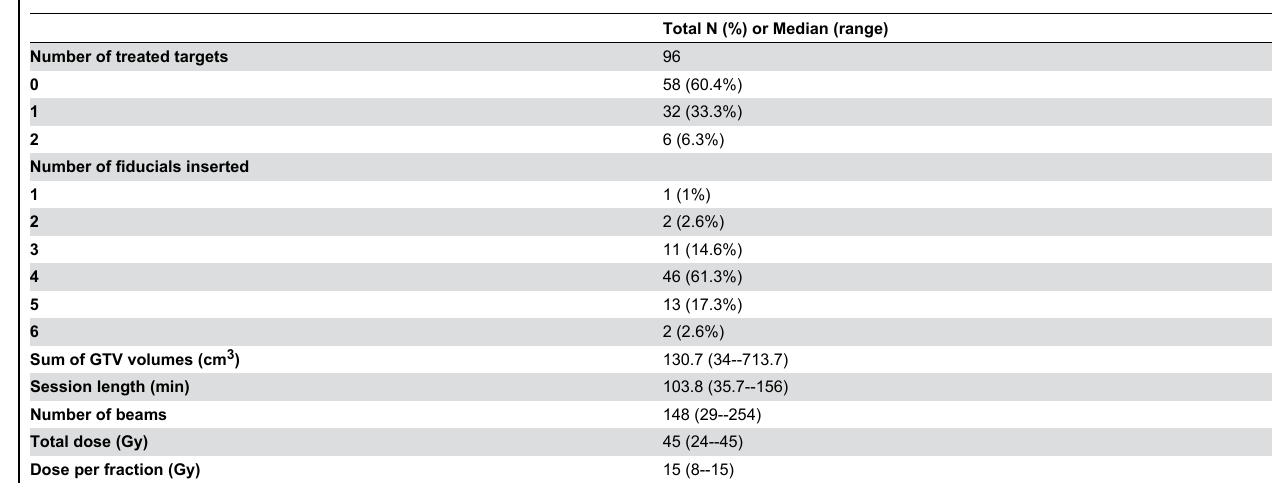
Table 3. Treatment